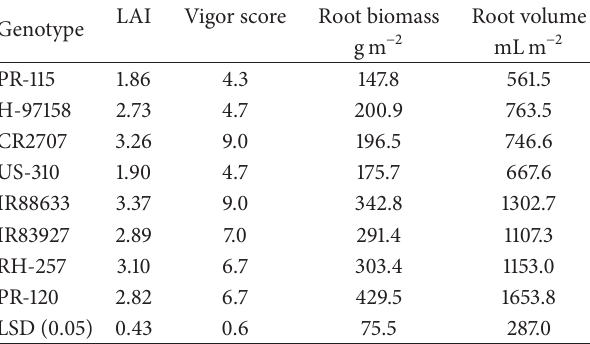
Table 7: Leaf area index (LAI) and vigor score at 28 days after sowing and root biomass and volume at flowering of various genotypes under weed-free